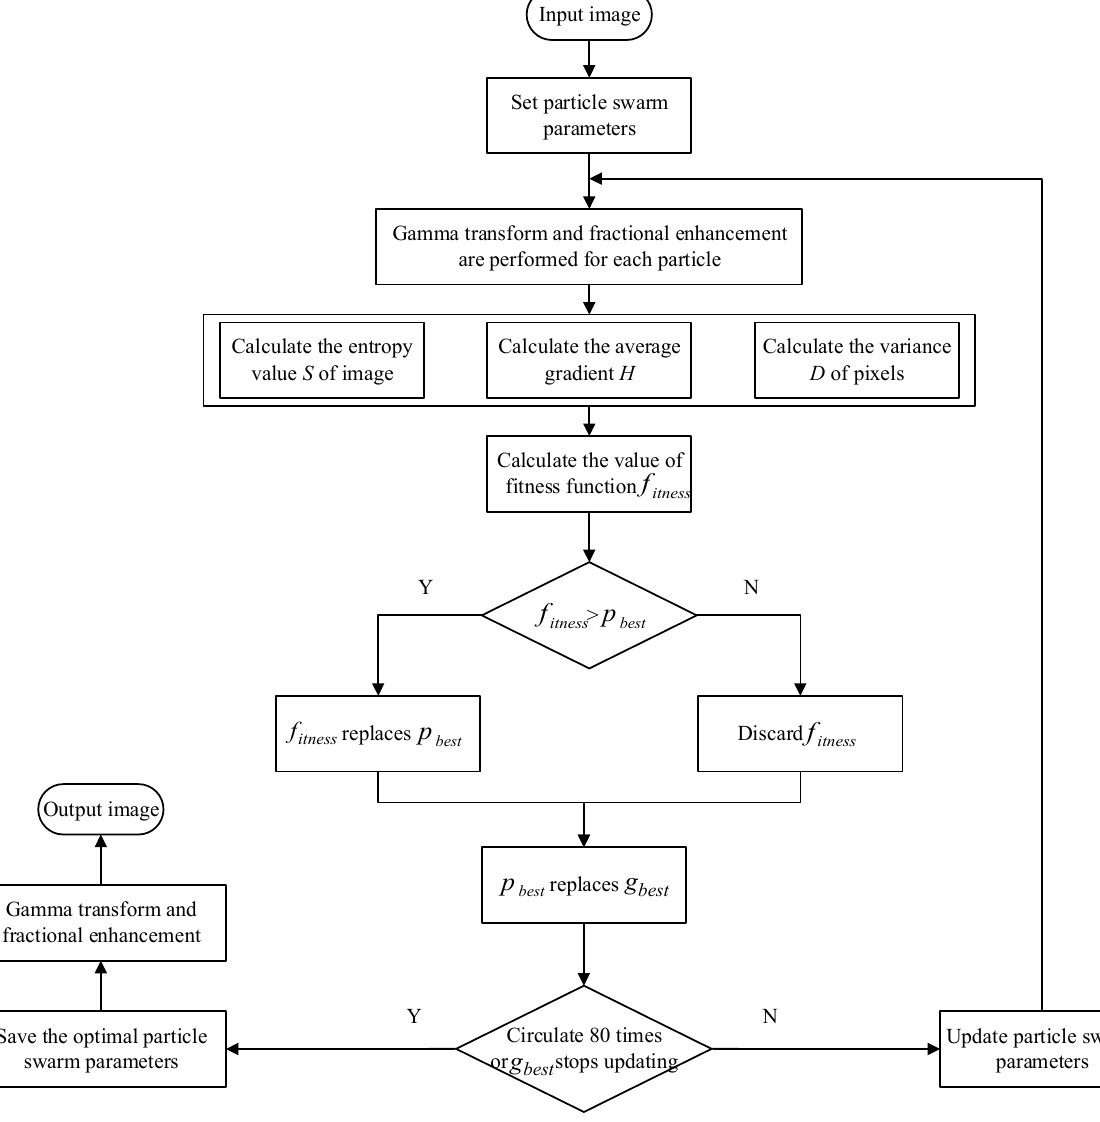
Figure 7. Flow chart of proposed image enhancement algorithm.